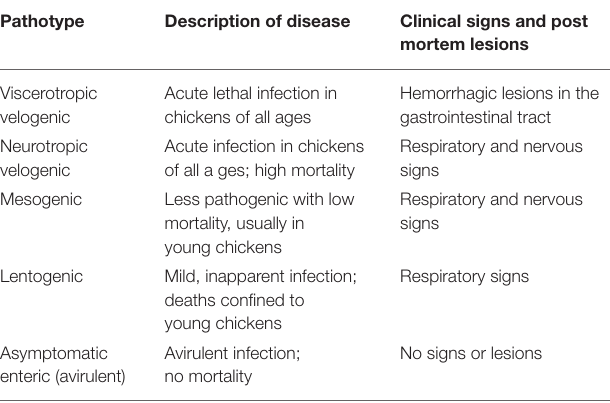
TABLE 1 | Pathotypes of Newcastle disease virus [Young et al. (7)]. Pathotype